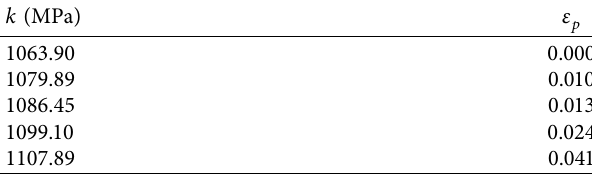
Table 3: k − ε p experimental data for 40CR steel.